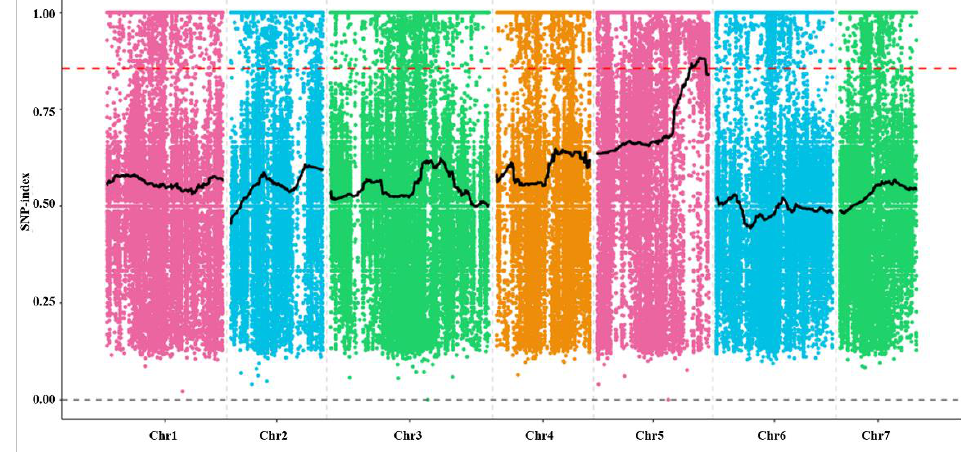
Figure 13. The association analysis of the SNP-index.